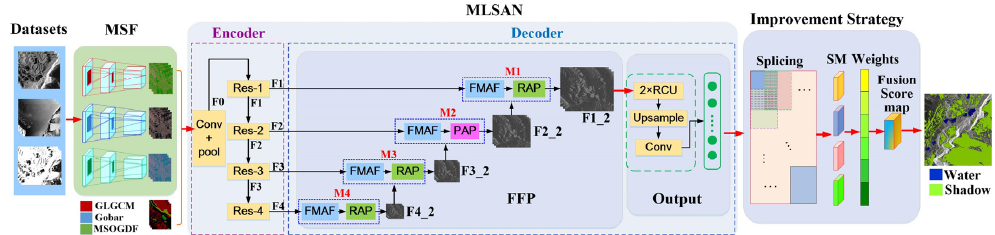
Figure 1. The framework of the Multi-scale Spatial Feature Multi-Level Selective Attention Network (MSF–MLSAN)